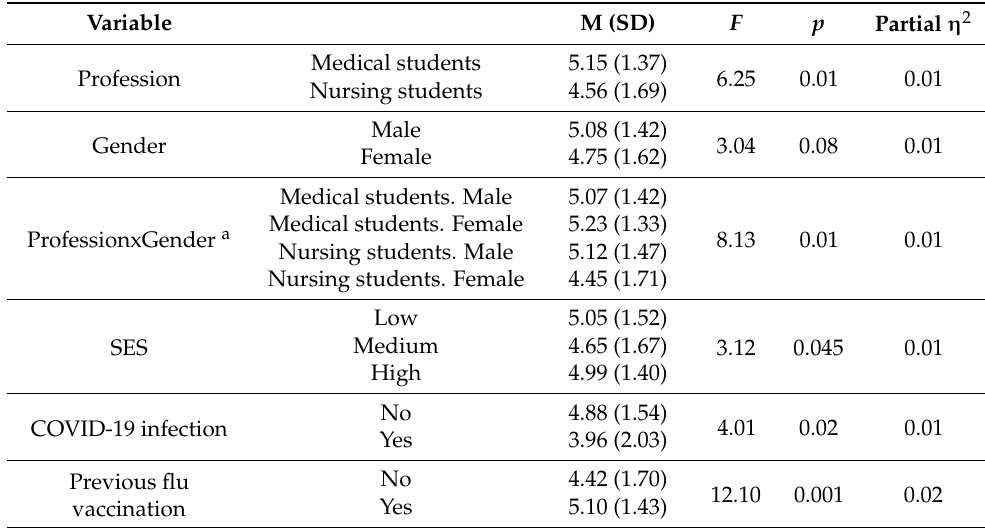
Table 2. The main significant effects and interactions obtained in the Two-Way Analyses of Variance (ANOVA) among the sociodemographic and health-related